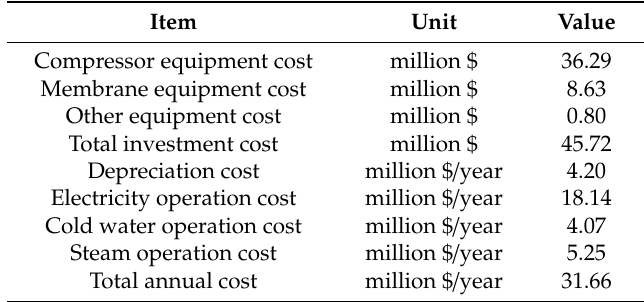
Table 4. The capital cost and operation cost of the NMGH process (excluding the reactor part).